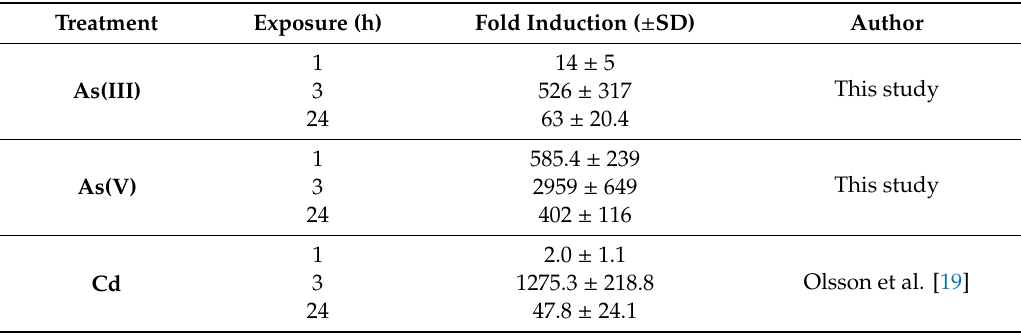
Table 3. Fold induction values and standard deviation (SD) from the qRT–PCR analysis of Chlamydomonas acidophila CaPCS2 gene obtained by quantitative RT–PCR after As or Cd exposure during 1, 3, and 24 h. The results are expressed as relative mRNA expression normalized to both control genes (housekeeping). Data are means ± SD of three independent experiments. Significant di ff erences between treated and non-treated cells are indicated by p <